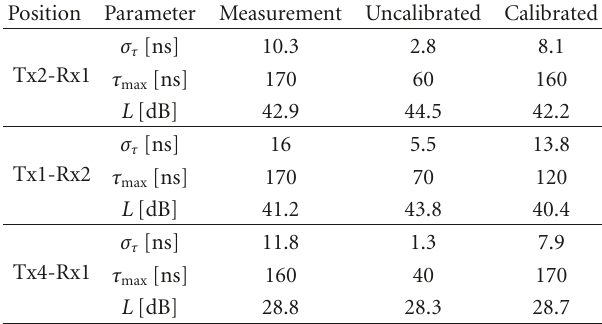
Table 2: Summary of results for the three